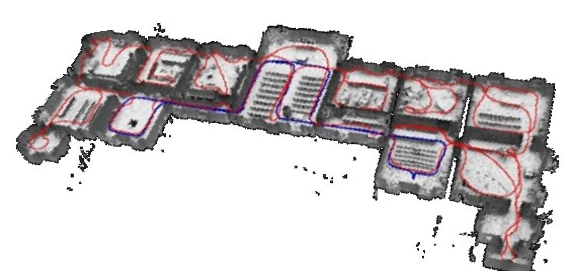
Figure 8. The two trajectories followed in the main floor of the Valentino Castle during the ZEB acquisitions